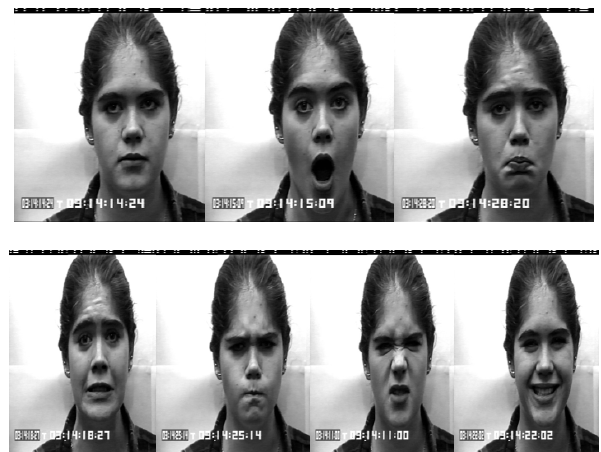
Figure 9. Partial image from the CK+ database.